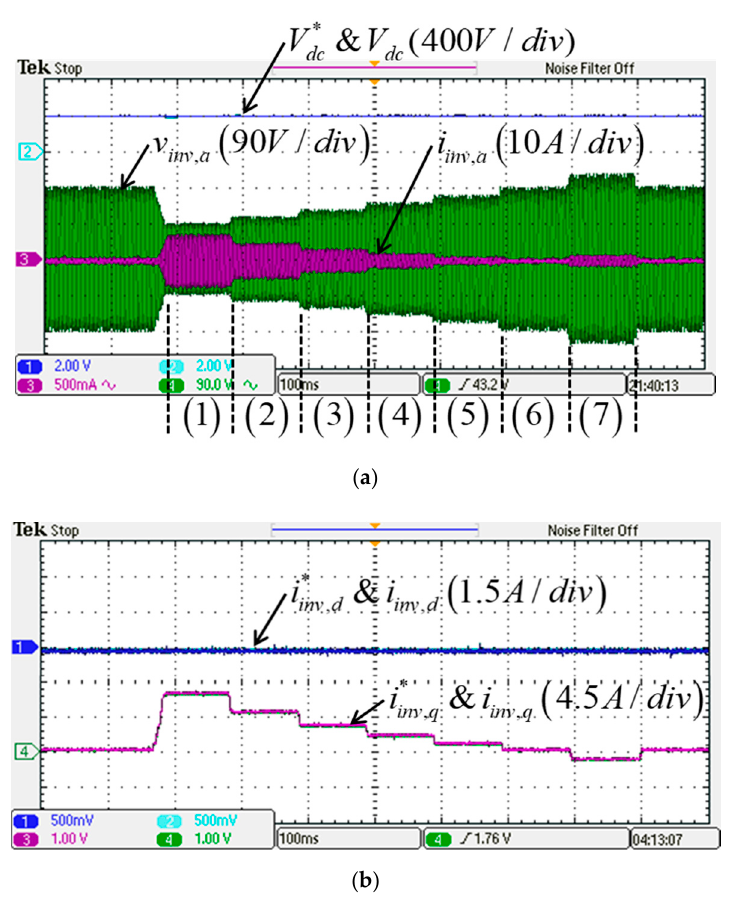
Figure 12. Implementation results of LVRT capability: ( a ) DC voltage and its command signal (400 V/div)/grid phase A voltage (90 V/div) and current (5 A/div); ( b ) inverter d-axis current and its command (1.5 A/div)/q-axis current and its command (4.5 A/div).